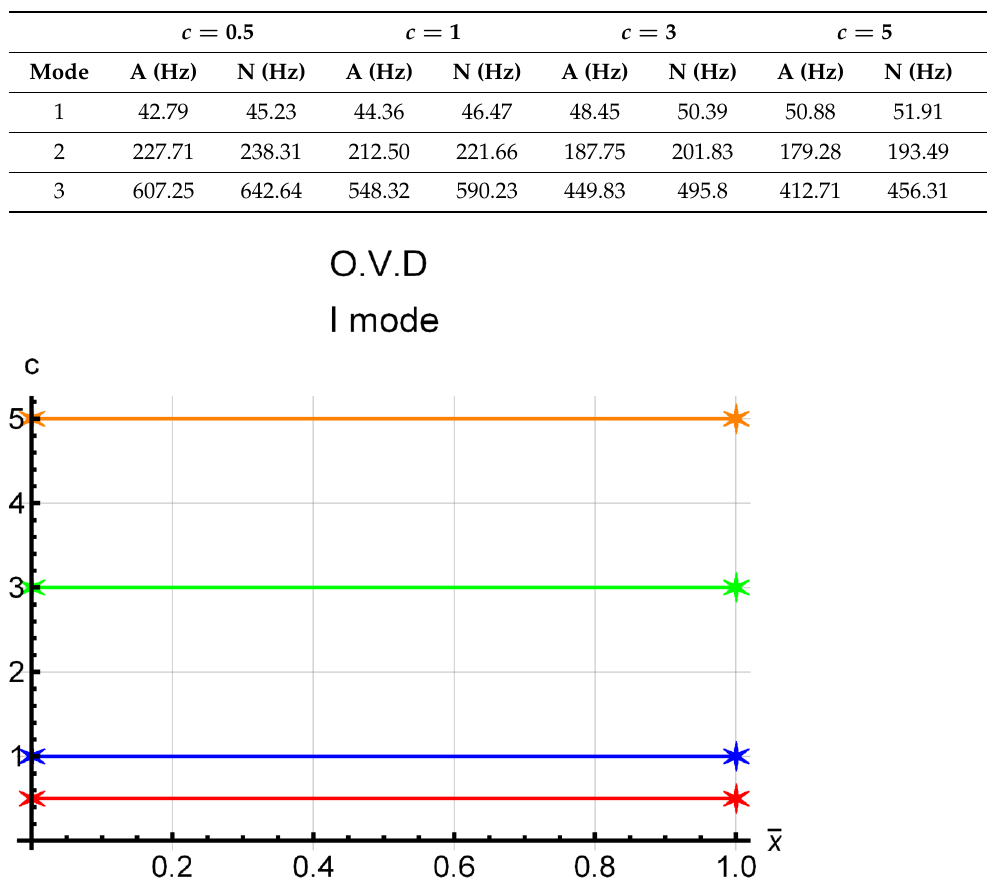
Figure 10. Analytical and numerical optimal voltage distributions (O.V.D.) for the first eigenmode excitation versus tapering ratio. The stars represent the numerical optimal voltage distribution for each c value, calculated considering 13 PZT